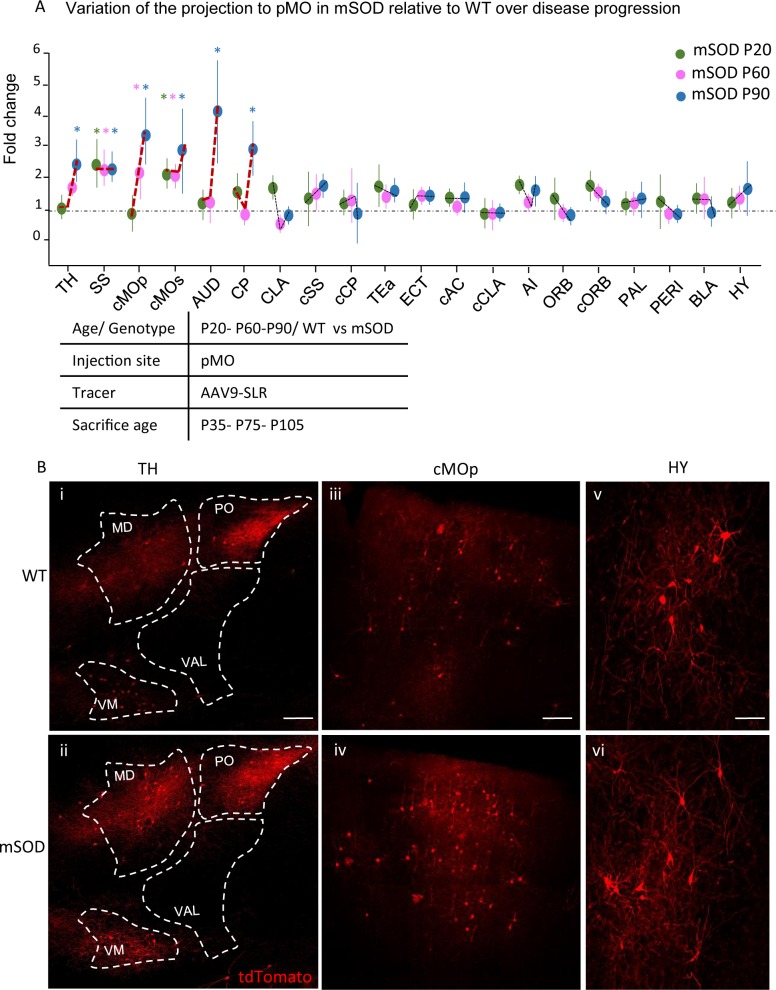
Progressive changes in projections to pMO in disease progression.(A) Projection neurons were mapped at P20, P60 and P90 timepoints; fold change of normalized total number of projecting neurons of mSOD vs WT was plotted for the three stages of disease progression. Values were expressed in terms of fold change over the corresponding WT for each time point. At P60 (WT N = 3, mSOD N = 4), increased connectivity persisted from SS (2.3 ± 0.5 in mSOD vs WT littermates, p=0.0108) and cMOs (2.0 ± 0.3 in mSOD vs WT littermates, p=0.0381), but, in addition, cMOp showed an increased projection to pMO (2.2 ± 0.8, p=0.0323 in mSOD vs WT littermates). At P90 (WT N = 5, mSOD N = 5), further significant increase in projection to pMO was found in: TH (2.4 ± 0.6 in mSOD vs WT littermates, p=0.0002), SS (2.2 ± 0.4 in mSOD vs WT littermates), cMOp (3.4 ± 1.0 in mSOD vs WT littermates, p<0.0001), cMOs (2.8 ± 1.3 in mSOD vs WT littermates, p<0.0001), AUD (4.0 ± 1.6 in mSOD vs WT littermates, p<0.0001) and CP (2.9 ± 0.7 in mSOD vs WT littermates, p<0.0001). (B) Representative images, for P90 stage, of neurons labeled by retrograde tracing from TH (i–ii), cMOp (iii-iv) and HY (v–vi). Scale bar 150 μm. Two-way ANOVA with Sidak correction for multiple comparison. Detailed statistic provided in Supplementary file 3a. Analysis of number of neurons in pMO for later stage (P90) mSOD animals provided in Figure 6—figure supplement 1A–B.10.7554/eLife.36892.022Figure 6—source data 1.Detailed statistic concerning projecting neurons to primary motor cortex (pMO) in WT vs mSOD animals, traced via AAV9-SLR injection, during disease progression.Three time points have been investigated: P20, P60 and P90. Total neuronal count is reported together with its normalization for the volume of the injection site. Moreover fold change for each time-point normalized over respective WT is provided.